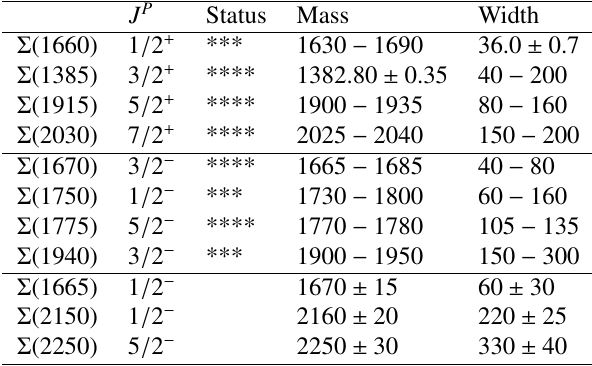
Table 1. Σ -Hyperons used in the first fit to the